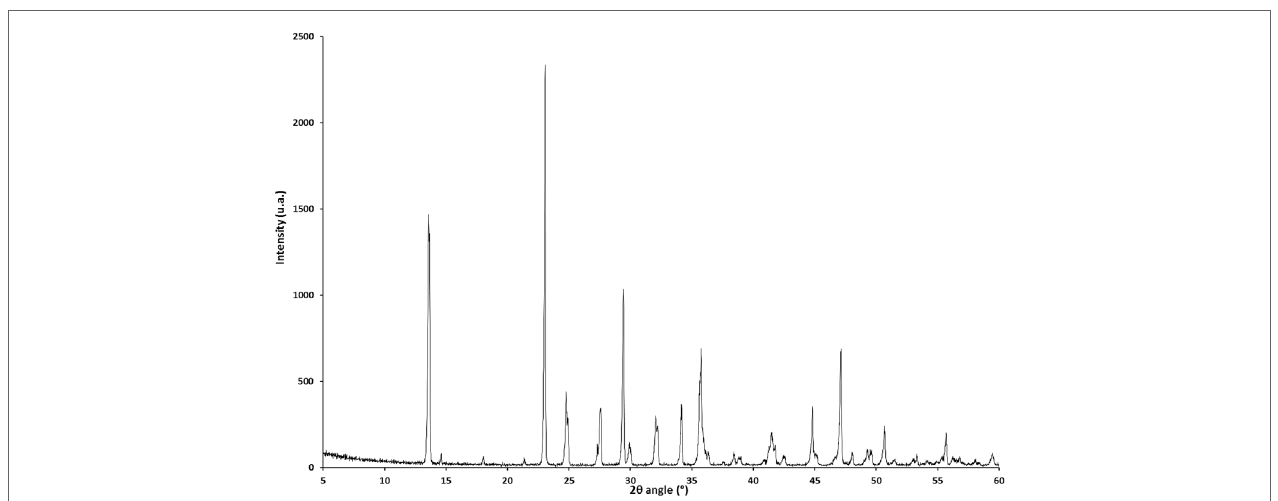
FigUre 3 | XrD pattern of nesquehonite (synthesis conditions: 25°c, 4 h, 0.1 mol of Mgcl 2 and na 2 cO 3 , total volume 1.1 l) in agreement with PDF #00-020-0669 (differences in intensity could be explained by the preferred orientation of the crystals)